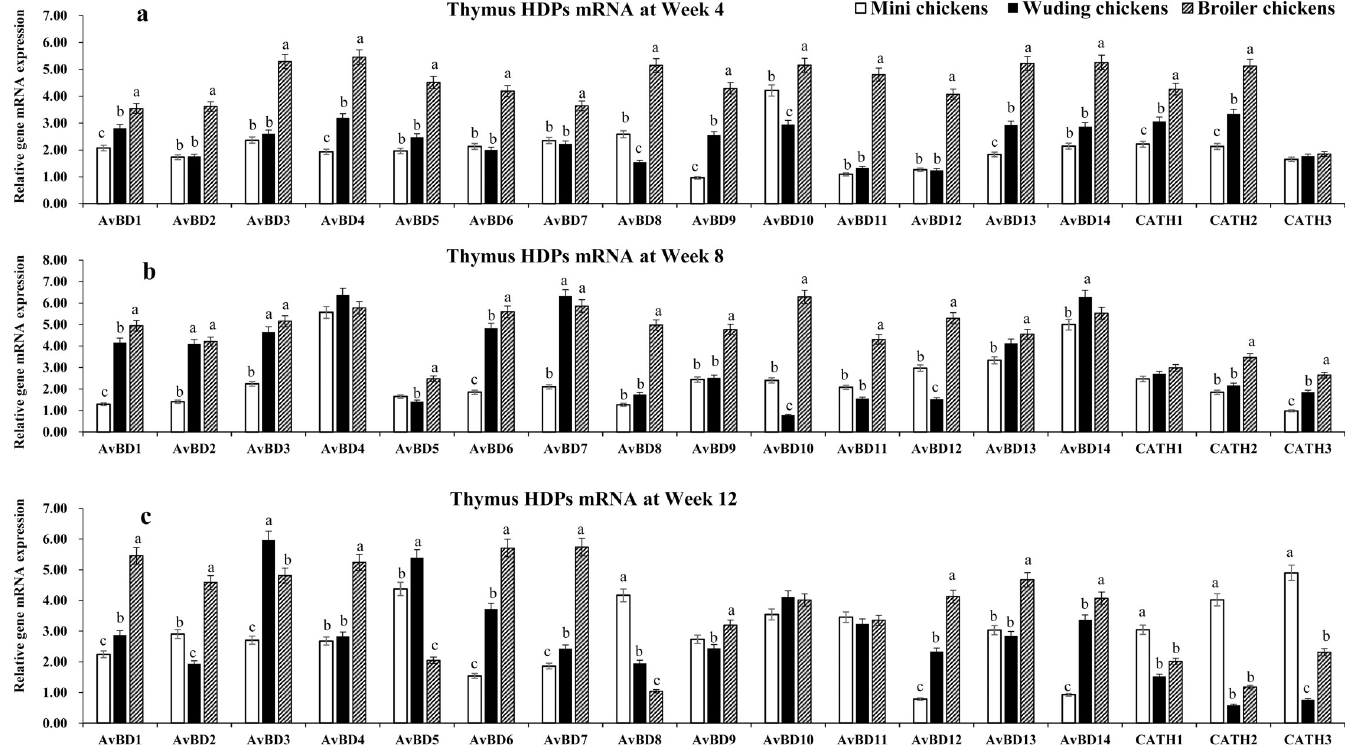
Fig 4. HDP mRNA expression in the thymus. Comparison analysis of mRNA expression of AvBD 1–14 and CATH 1–3 genes in the thymus of three chickens at weeks 4 (a), 8 (b), and 12 (c). Twenty chickens per type per time point were used and gene expression was investigated with RT-qPCR. The experiment was repeated three times. Data are expressed as the mean ± SEM at each age for each breed and different letters on top of each bar represent significant differences (p < 0.05) among chickens.